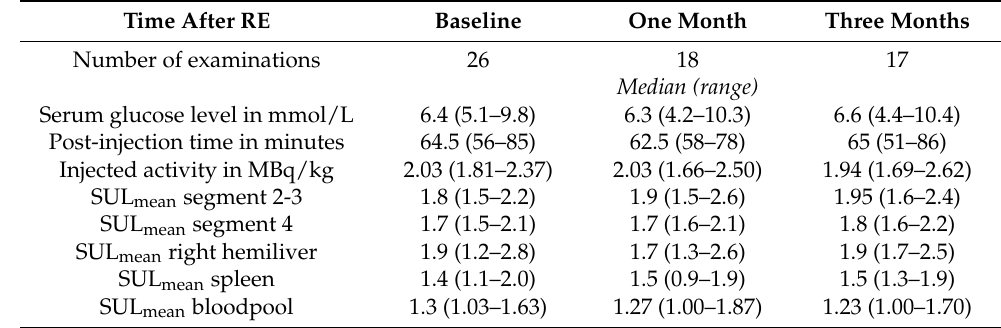
Table 2. F-18 FDG-PET/CT specifications and measurements of the study